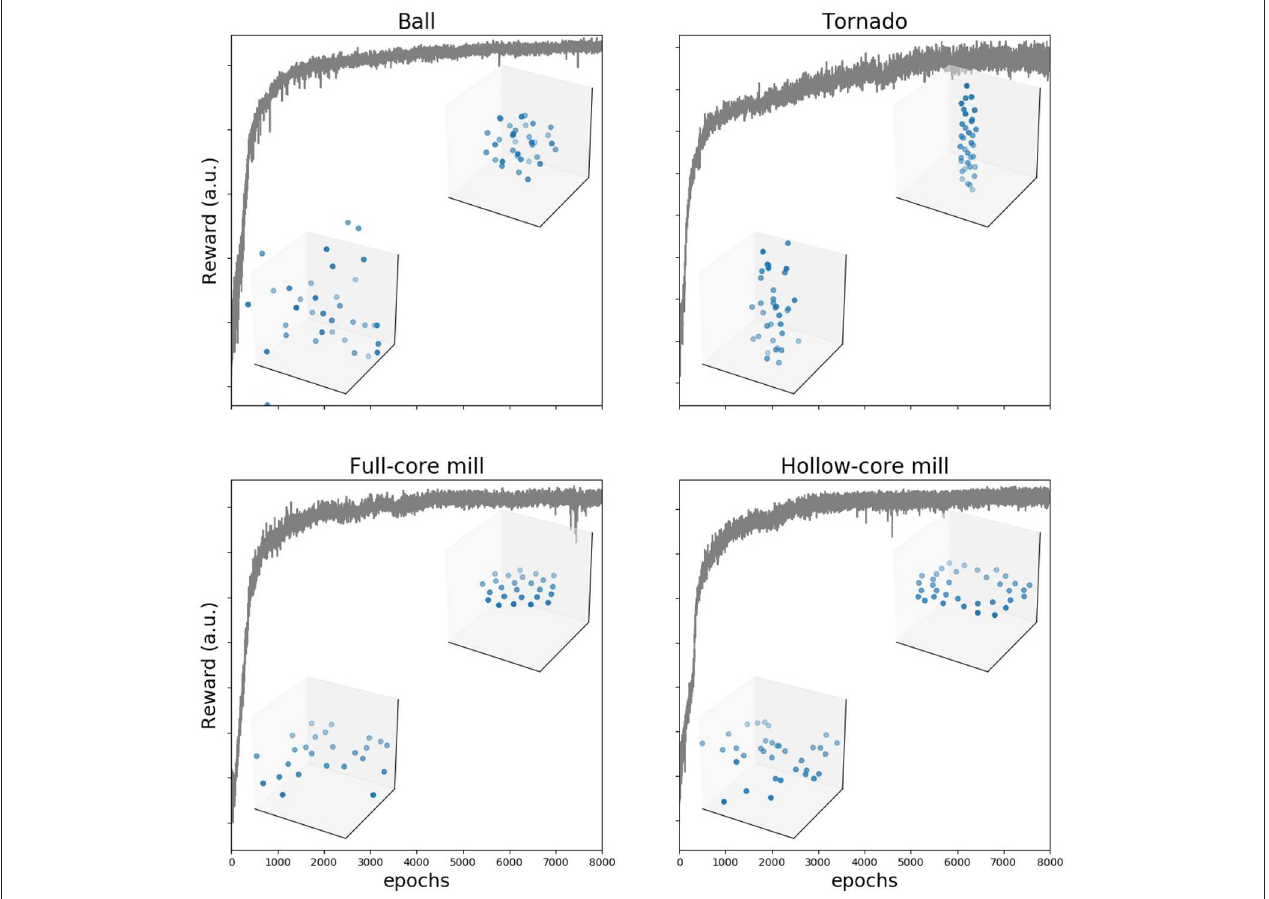
FIGURE 3 | Training makes reward to increase and group behavior to converge to the desired configuration. Reward as a function of number of training epochs in an example training cycle for each of the four configurations. In each of the examples, we show two frames (agents shown as blue dots) from the generated trajectories, one early in the training process (100 epochs) and a second after the reward plateaus (8,000